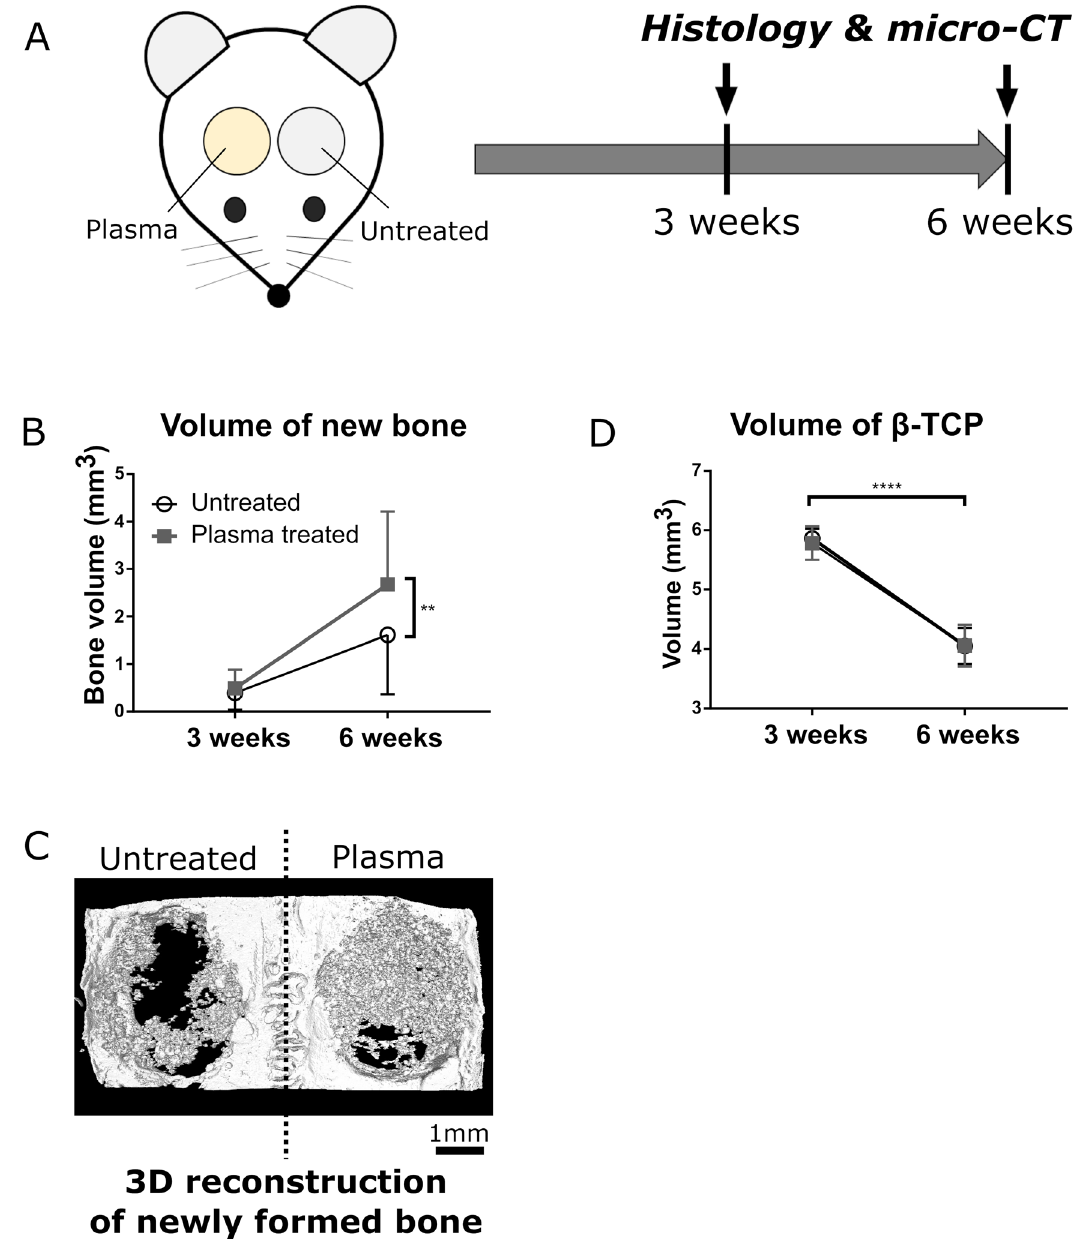
Figure 6. In vivo experiments on the new bone formation inside porous β-TCP disks. ( A ) Schematic diagram of the in vivo implantation of porous β-TCP disks and post-operative evaluations (drawn by using Microsoft PowerPoint 2016). ( B ) Micro-CT analysis of new bone volumes formed inside the untreated (open circles) and plasma-treated (filled squares) porous β-TCP disks at postoperative 3 and 6 weeks. ( C ) The 3D reconstruction of the calvarial bone implanted with untreated (left) and plasma-treated (right) porous β-TCP disks at postoperative 6 weeks. The gray grain-like structures indicate newly formed bone, and the white plate or slab-like structure with two circular holes represents the rat calvarial bone. The β-TCP disks are not depicted and therefore the volume occupied by β-TCP is represented by void space (black) in this image. ( D ) Micro-CT analysis of residual β-TCP volumes of the untreated (open circles) and plasma-treated (filled squares) porous β-TCP disks at postoperative 3 and 6 weeks. The data in B and D are expressed as mean ± SD (n = 5 for 3 weeks, n = 15 for 6 weeks). ** p < 0.01, **** p < 0.0001. Wilcoxon matched-pairs signed-rank